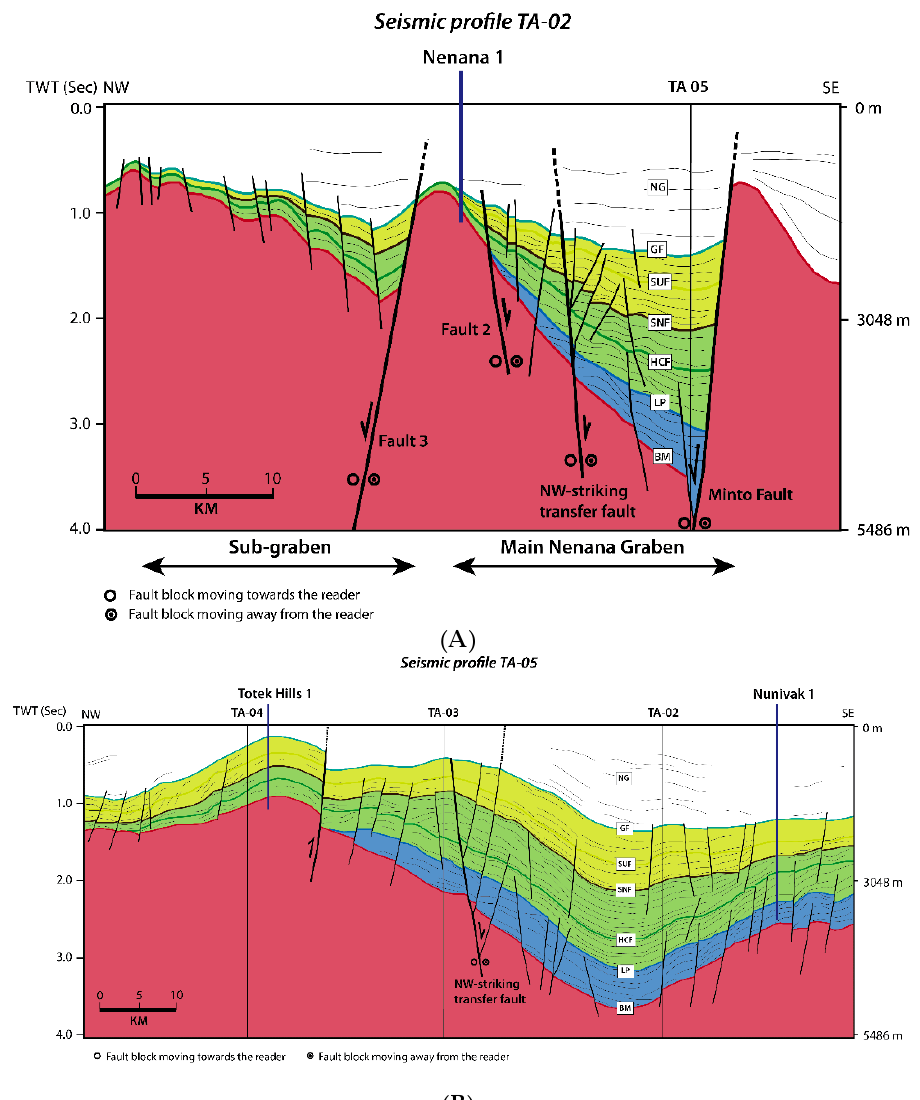
Figure 6. ( A ) Structural interpretation of seismic profile TA-02 across the Nenana basin. ( B ) Structural interpretation of seismic profile TA-05 along the Nenana basin. See Figure 5 for the location of seismic profiles TA-02 and TA-05. BM— basement; LP—Paleocene formation; HCF—Healy Creek formation; SNF—Sanctuary formation; SUF—Suntrana formation; GF—Grubstake formation; NG—Nenana gravel.